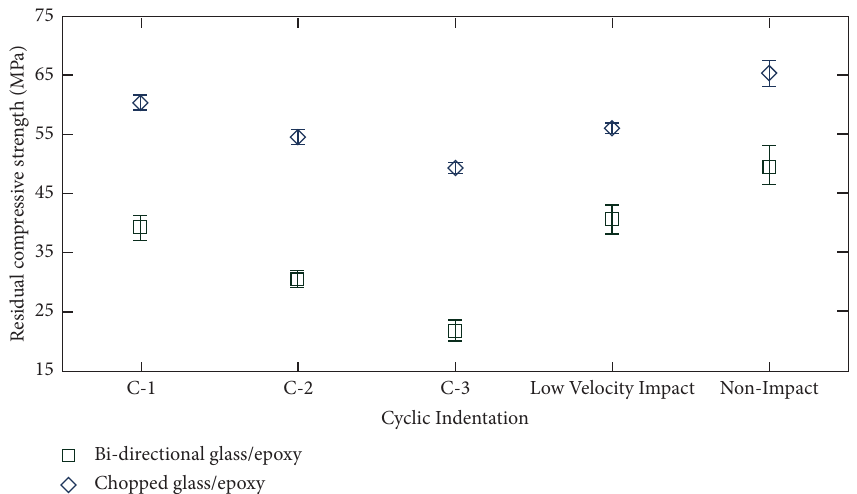
Figure 11: Residual compressive strength of bidirectional and chopped laminates.